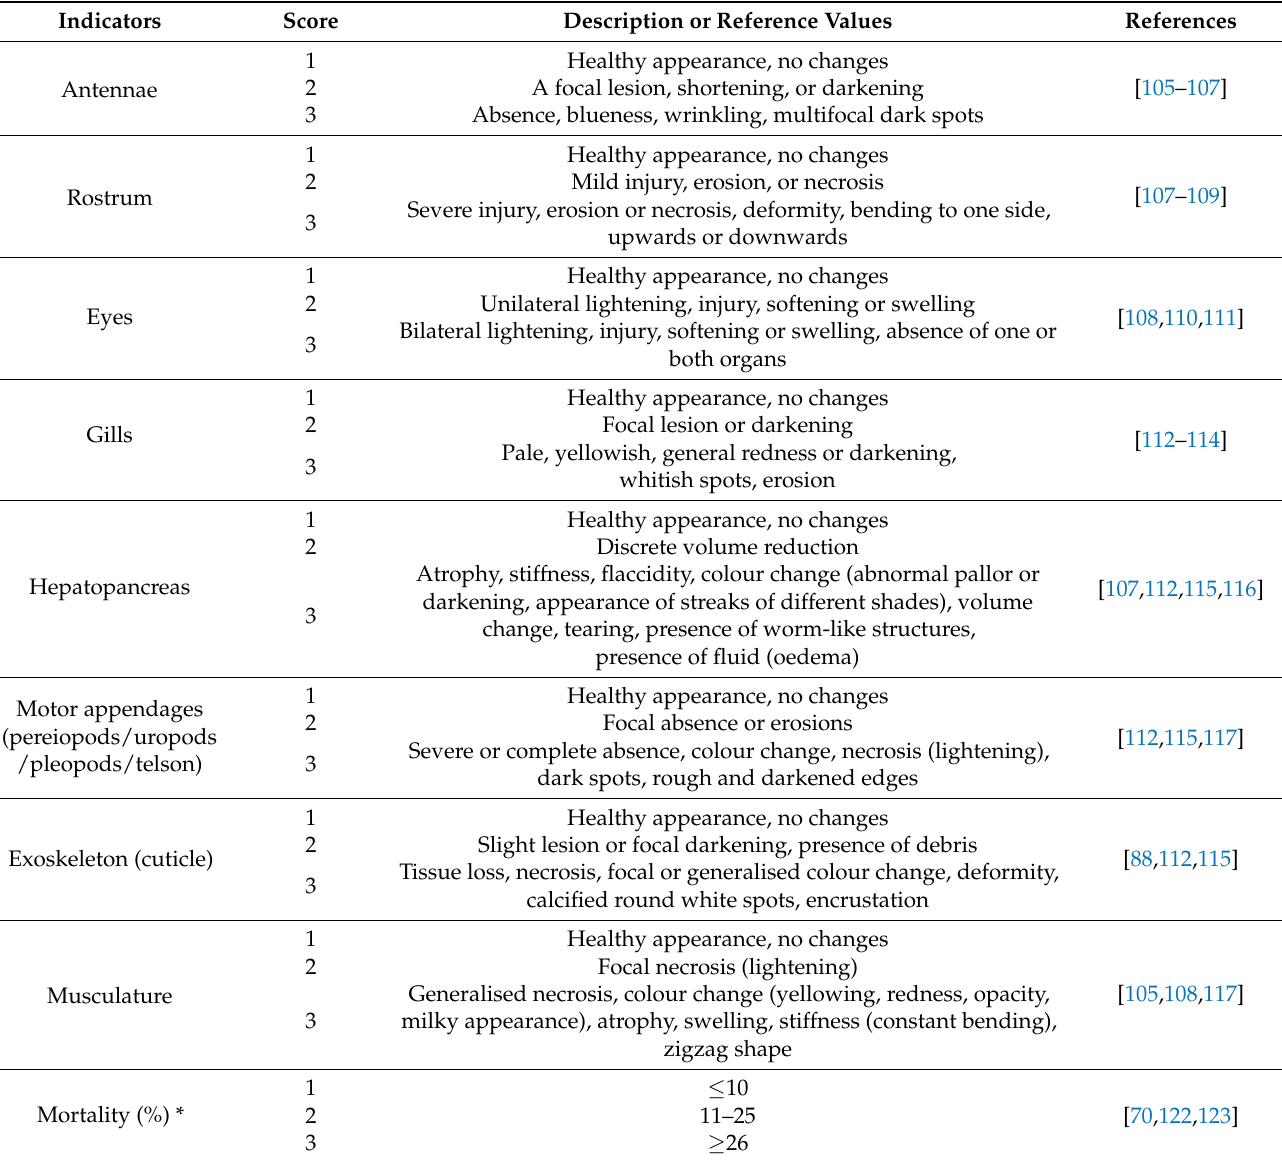
Table 12. Health indicators for Penaeus vannamei